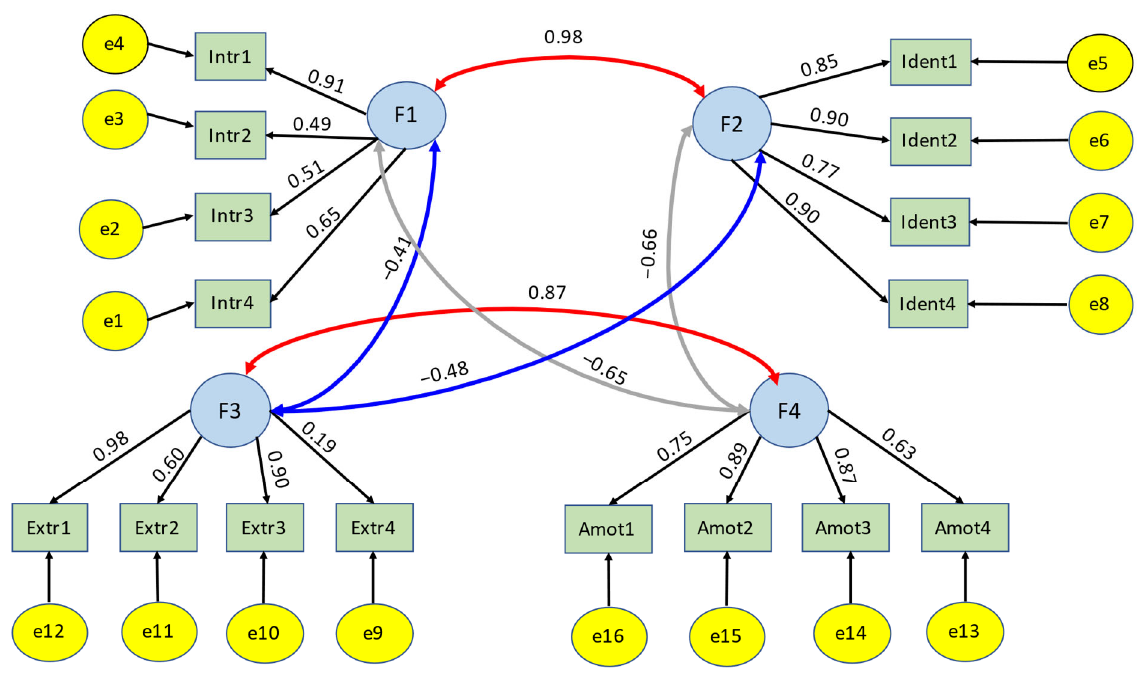
Figure 4. Four-factor structure of the SIMS instrument for validation of the instrument, standard regressions estimates are on the paths; Intr1, ntr2, Intr3, Intr4 variables measuring internal motivation, Extr1, Extr2, Extr3, Extr4 manifest variables measuring external regulation, ident1, ident2, ident3, ident4 manifest variables measuring identified regulation and Amot1, Amot2, Amot3, Amot4 manifest variables measuring amotivation.